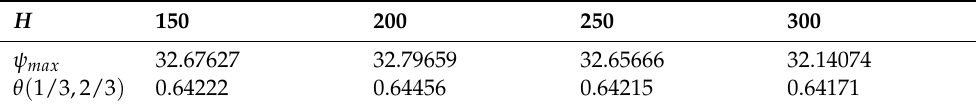
Table 1. Effect of the length H on the value of ψ max and θ ( 1/3,2/3 ) for Ra = 10 6 -case